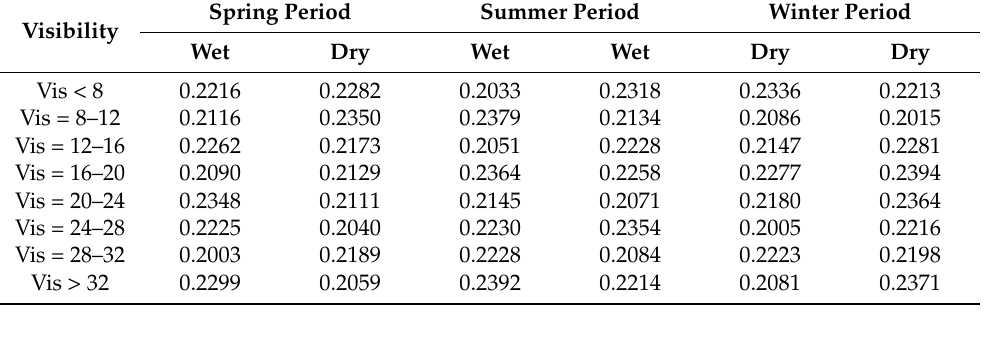
Table A4. Results of K-S calculations (probability p) showing the agreement of empirical and theoret- ical distributions describing the air quality index (API) in the corresponding range for precipitation and rain days for spring, summer and winter seasons.